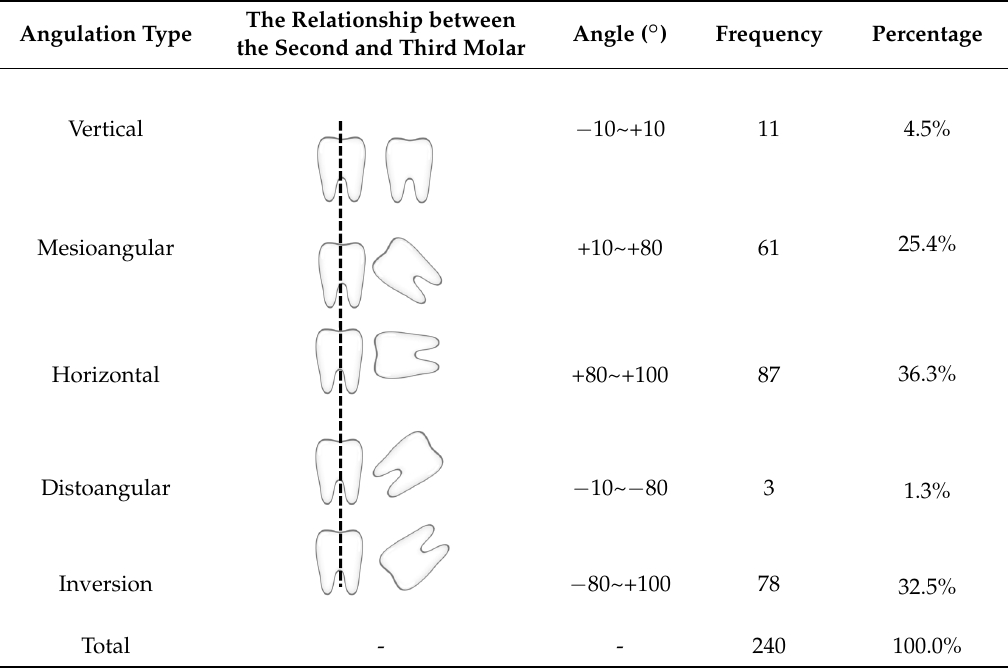
Table 3. The associated mandibular third molar angulation.